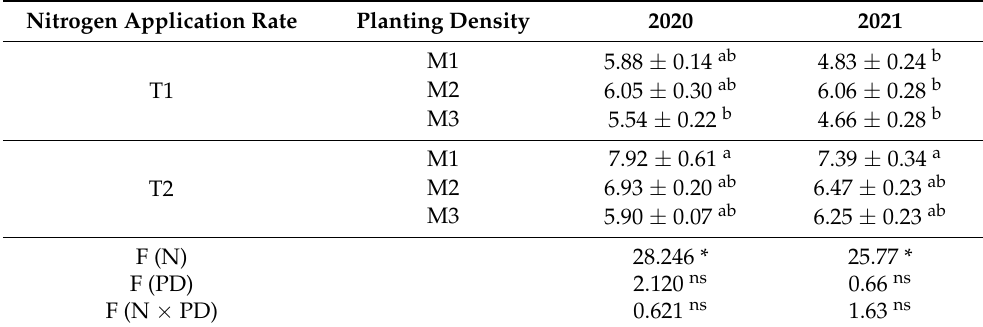
Table 2. Effects of the nitrogen application rate and planting density on the LAI of rice at the head- ing stage.